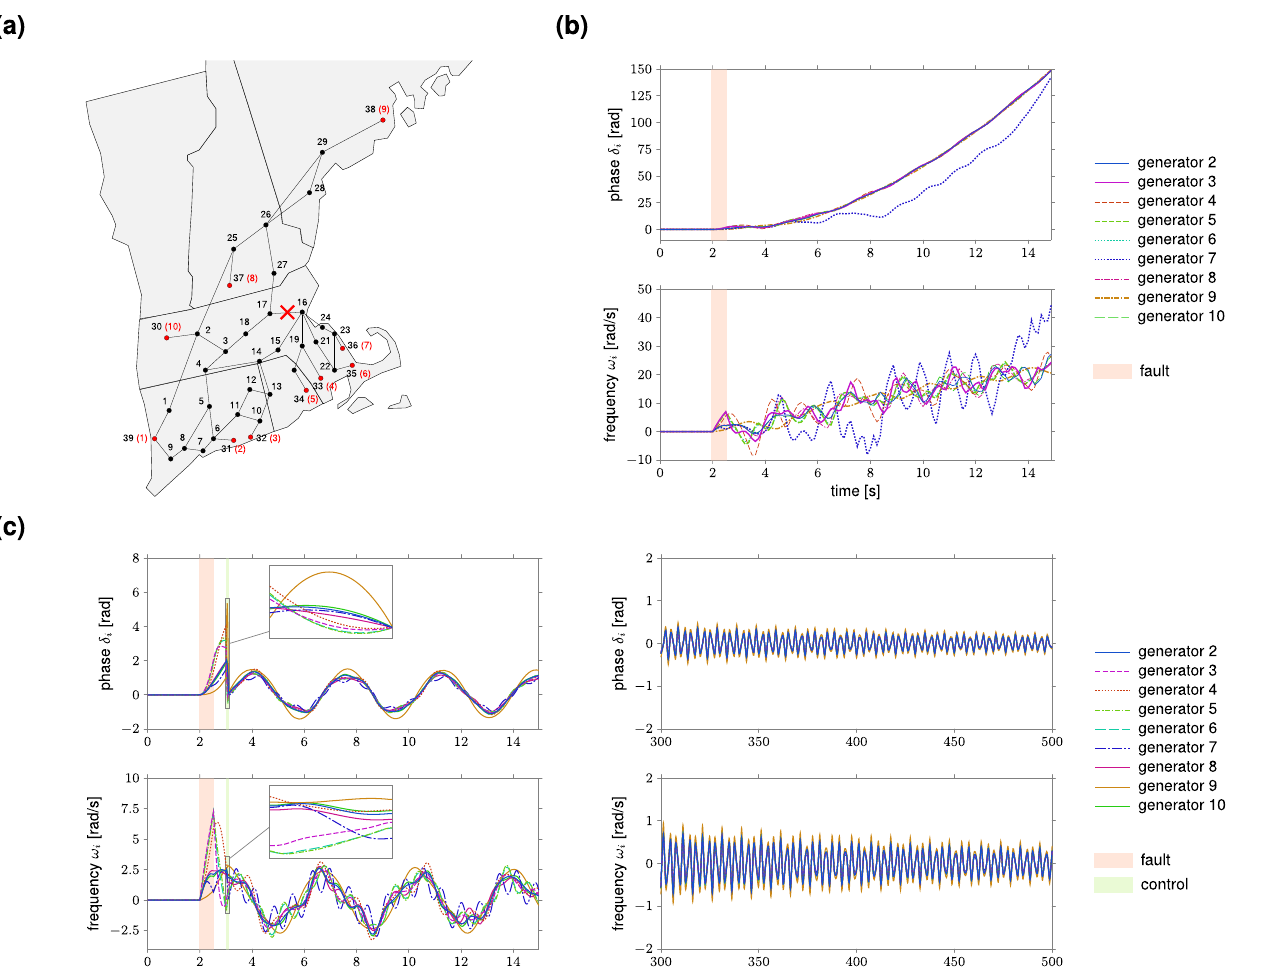
Fig. 5 Data-driven fault recovery in the New England power-grid network. Panel ( a ) depicts the 39-node New England power-grid network (see ref. 70 , Appendix A). The black nodes {1, … ,29} represent load nodes, while the red nodes {30, … , 39} are power generators. The generators are labeled according to the numbers in the red brackets. The red cross denotes the location of the fault. Panel ( b ) plots the behavior of the phases and frequencies of generators {2, … , 10} after the occurrence of the fault. The onset time of the fault is t = 2s and the fault duration is 0.5s (red area in the plots). At time t = 2.5s the fault is cleared. The phase and frequency of generator 1 (not shown) are fi xed to a constant (see “ Methods ” ). The left plots of the panel ( c ) show the behavior of the phases and frequencies of generators {2, … , 10} after the application of the data-driven control input (4). The duration of the control action is 0.1 s (green area in the plots) which corresponds to a control horizon T = 400 for the discretized network dynamics with sampling period T s = 2.5× 10 − 4 s. For the computation of the control input, we employ N = 4000 experimental data collected of fl ine by perturbing the state of the generators locally around its steady-state value (see “ Methods ” ). We use weighting matrices R = I and Q = ε I , with ε = 0.01. The insets illustrate the behavior of the phases and frequencies during the application of the control. The right plots of the panel ( c ) show the asymptotic behavior of the phases and frequencies of generators {2, … , 10} after the application of the data-driven control